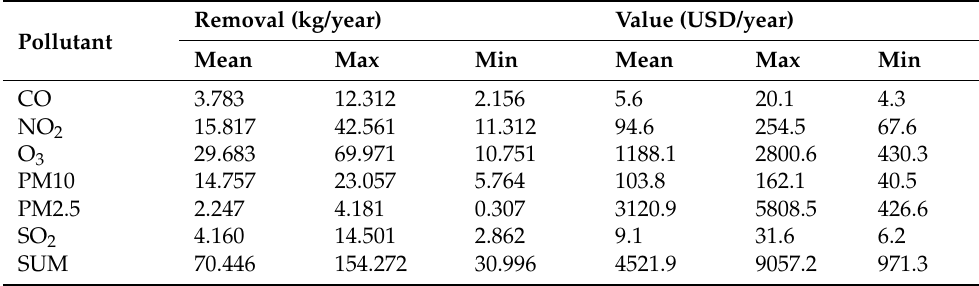
Table 2. Pollution removal and value by trees and shrubs—annual